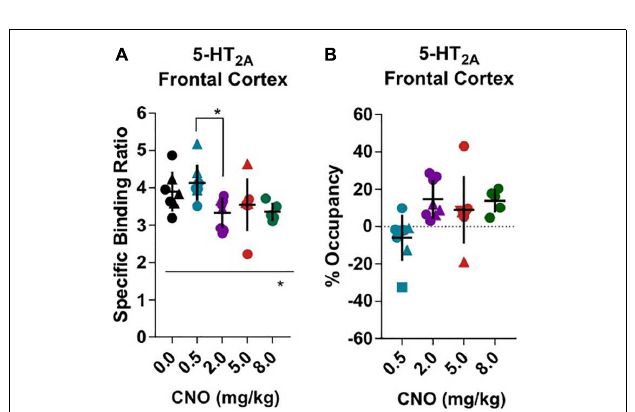
FIGURE 2 | Serotonin 5HT 2 A ex vivo specific binding ration of [ 18 F]MH.MZ and the CNO induced occupancy. Male rats are round and females are triangular. Horizontal line and ∗ represents a significant effect of treatments, as measured with a one-way ANOVA ( ∗ p < 0.05, ∗∗ p < 0.01 and ∗∗∗ p < 0.001).